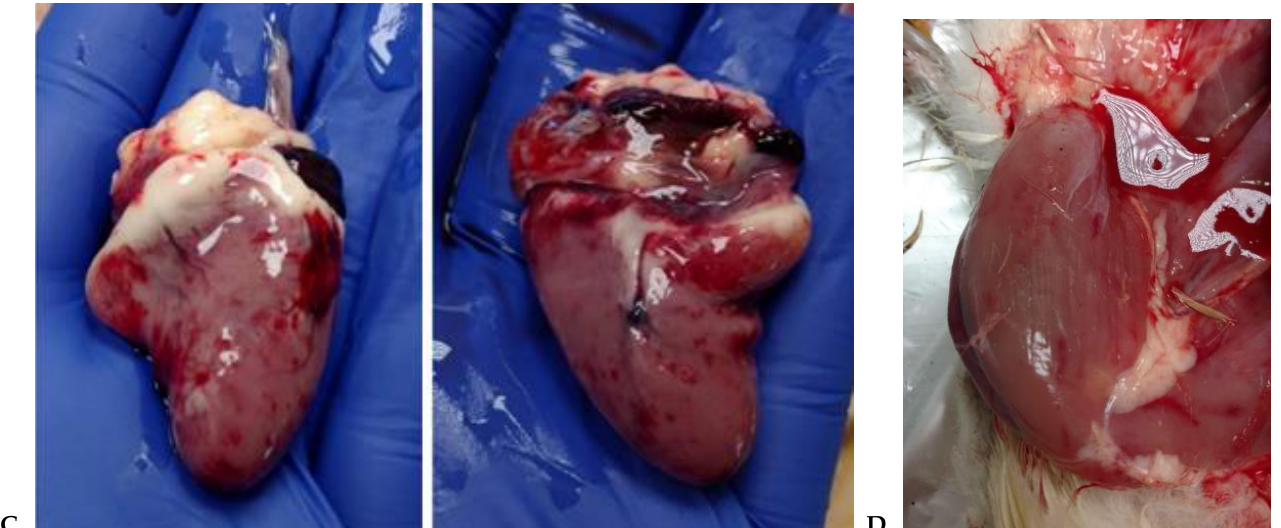
C. D. Figure 1. ( A ) disseminated, white necrotic spots in an enlarged and congested liver; ( B ) enlarged and congested spleen with clear foci suggestive of necrosis; ( C ) epicardial multifocal to coalescing haemorrhage on the surface of the heart muscle; ( D ) Leg muscle haemorrhages and subcutaneous oedema from a GRV infected goose.